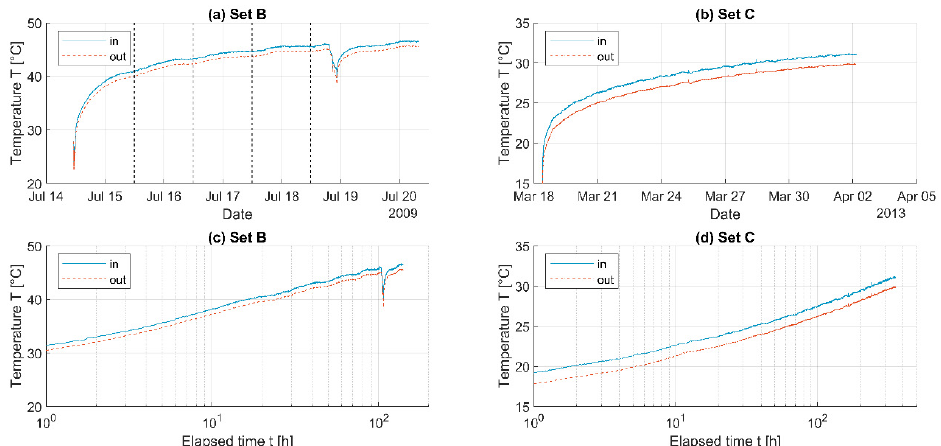
Figure 4. Evolution of the pile inlet (in) and outlet (out) temperatures for ( a ) set B and ( b ) set C; ( c ) set B and ( d ) set C as a function of the logarithmic elapsed time. In subplot ( a ) the dotted vertical lines enlighten the daily temperature variations.